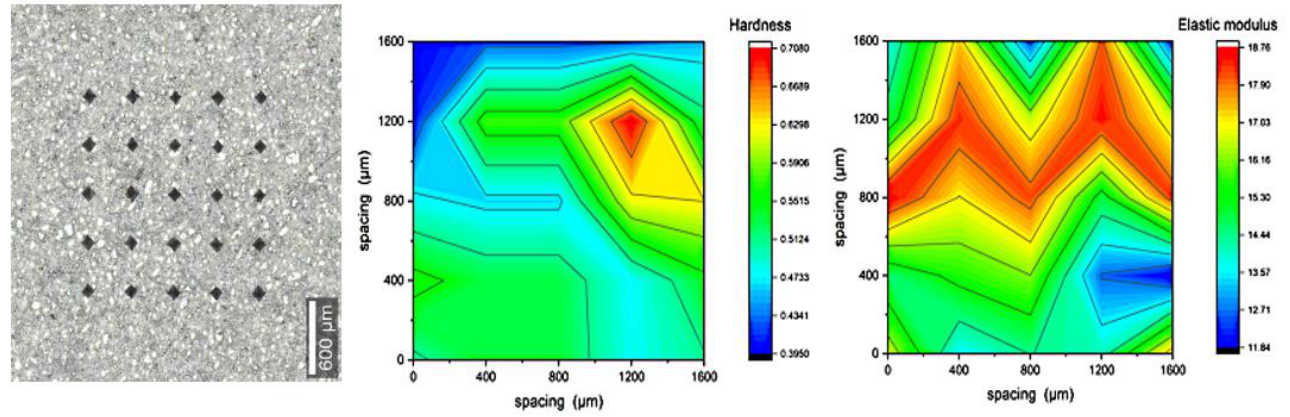
Figure 9. Indentation results for polished cores of neat cement with 25 indents, represented as maps of hardness (avg. of 0.506 GPa) and elastic modulus (avg. of 15.72 GPa).